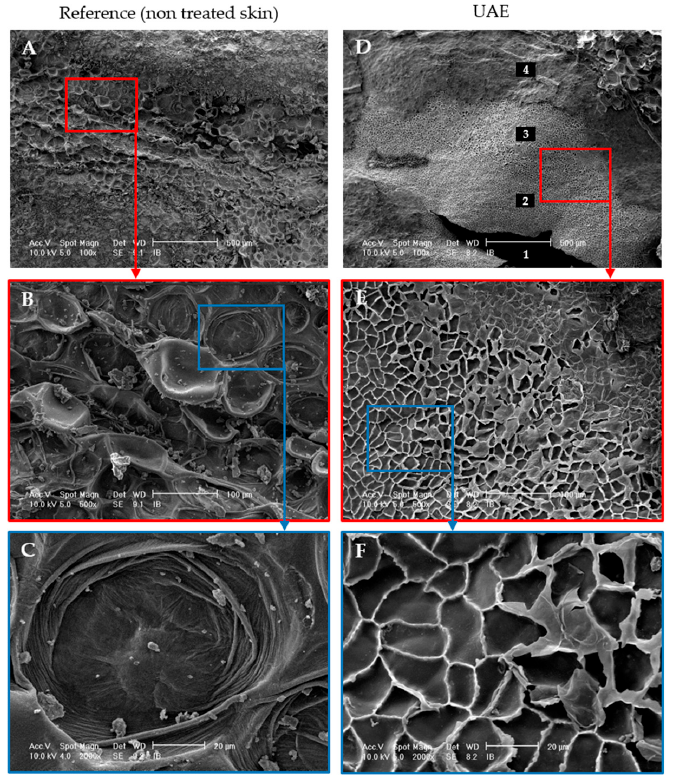
Figure 4. SEM observation of almond skin before ( A,B,C ) and after ( D,E,F ) localized sonication.